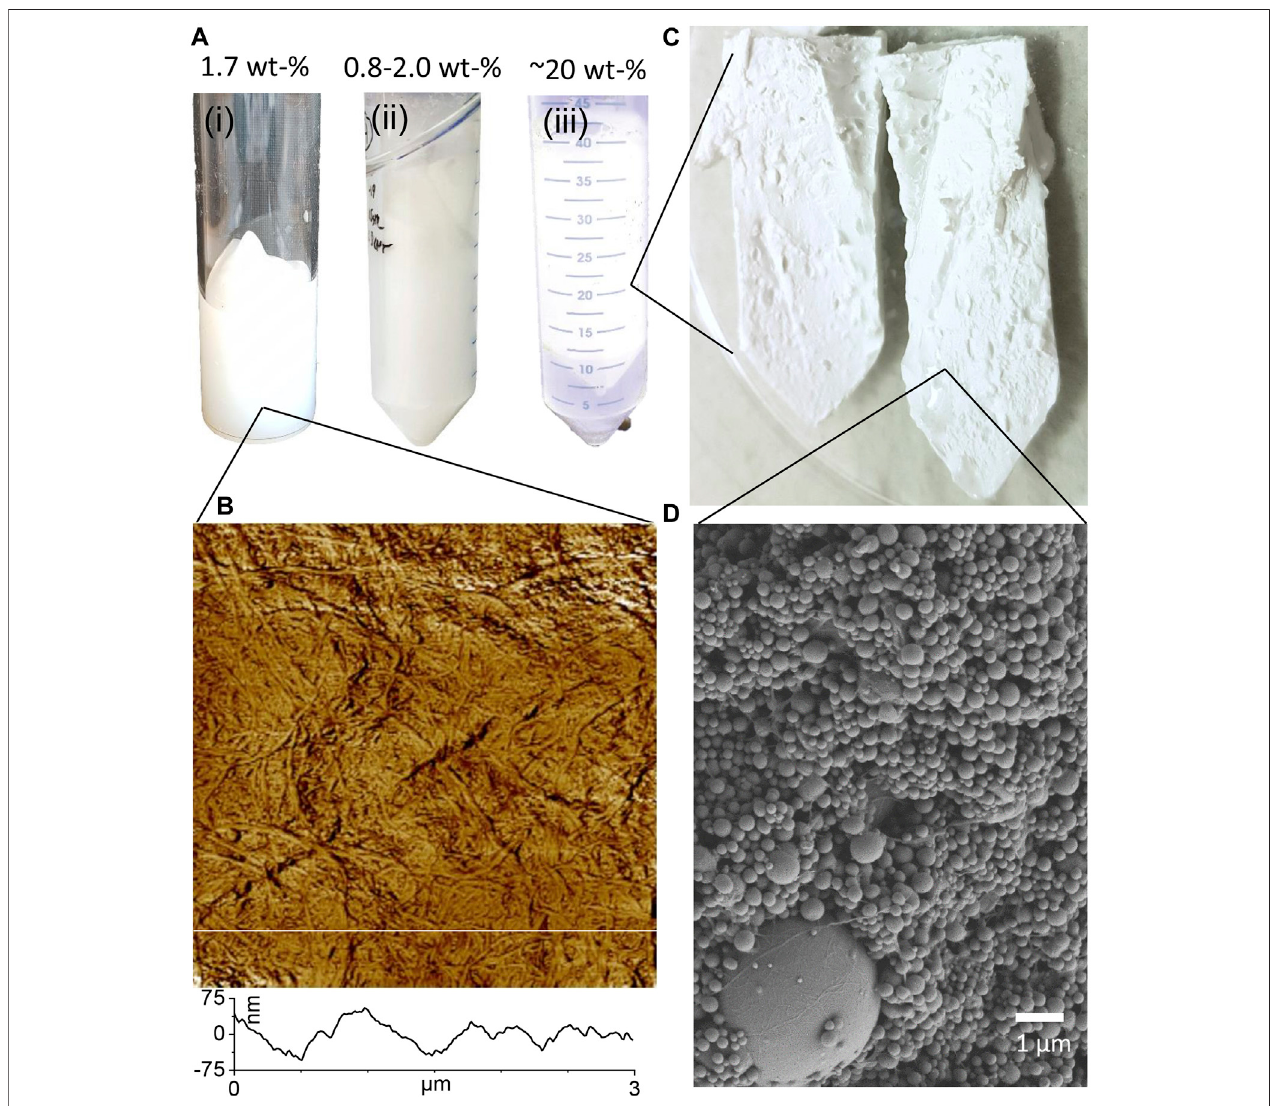
FIGURE2|(A) Photographsof(i)mechanicallydisintegratedCNFgel,(ii)freshlypreparedemulsion(iii)andpolymerizedemulsion. (B) 3 × 3 µmAFMphasecontrast image of CNF fi brils, and graph of height pro fi le corresponding to segment line. (AFM height contrast image available in Supplementary Figure S1 ). (C) Photograph of creaming layer cut into two halves after discarding the excess water. (D) SEM image of the structure of the dried creaming layer containing only CNF (CNF100).